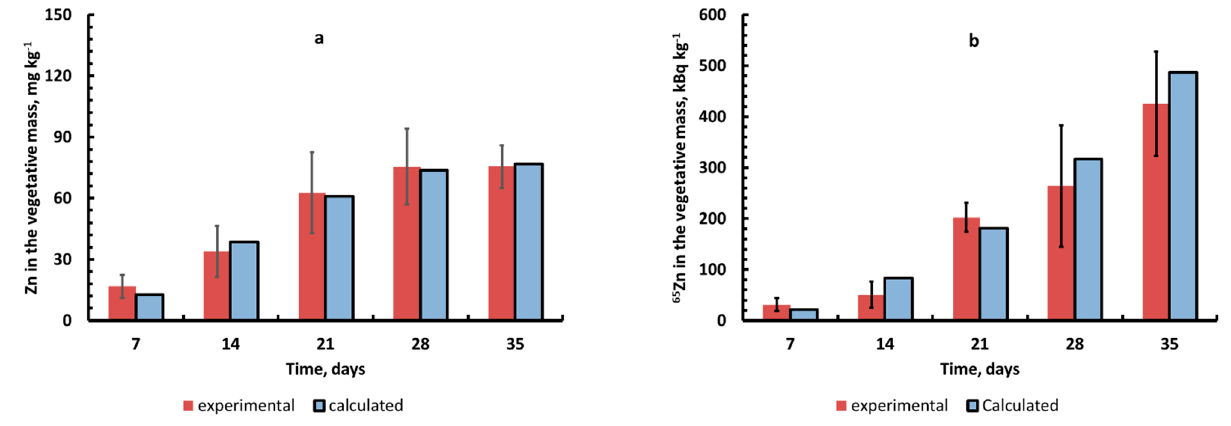
Figure 9. Dynamics of Zn concentration in mg kg − 1 ( a ); mass activity concentration of 65 Zn ( b ) (mean values ± standard deviation; n = 3).